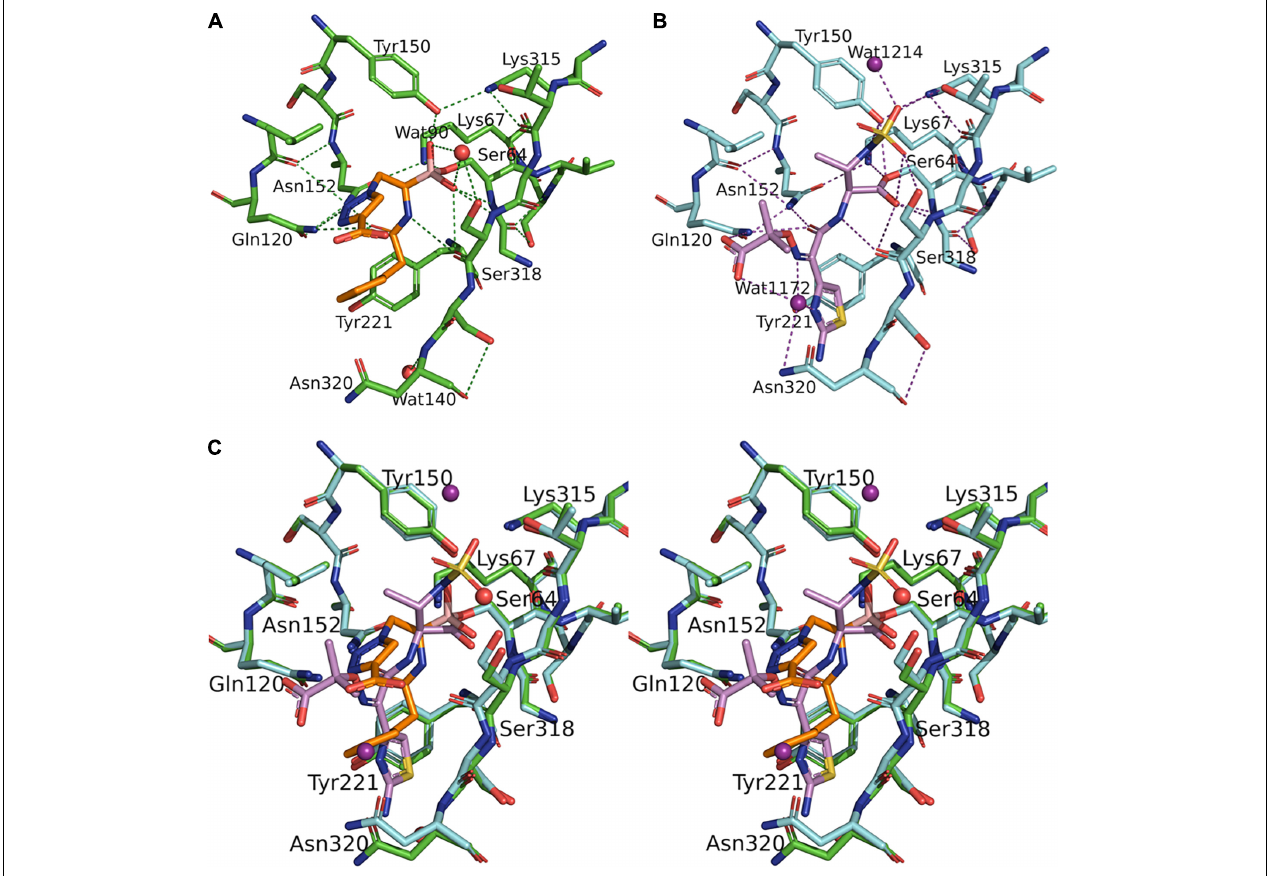
FIGURE 2 | Structural comparison between S02030: MOX-1 and ATM: MOX-1. Hydrogen-bonding pattern between S02030 and MOX-1 (A) and between ATM and MOX-1 (B) . (C) Superposition of active site structures of S02030: MOX-1 (orange: green) and ATM: MOX-1 (violet: cyan).